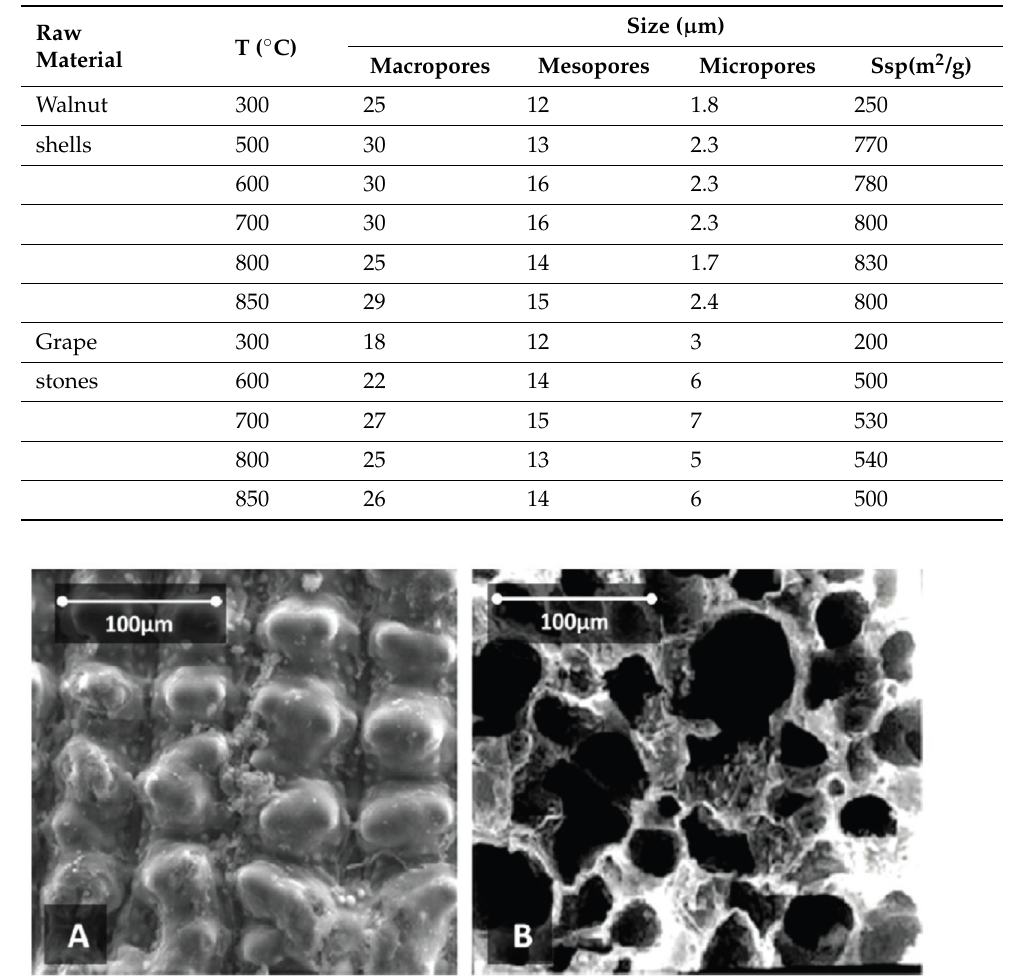
Table 2. Specific surface and pore size of the samples carbonized at different temperatures. Reprinted with permission from Ref. [50]. Copyright 2020, Jenny Stanford Publishing Pte. Ltd.